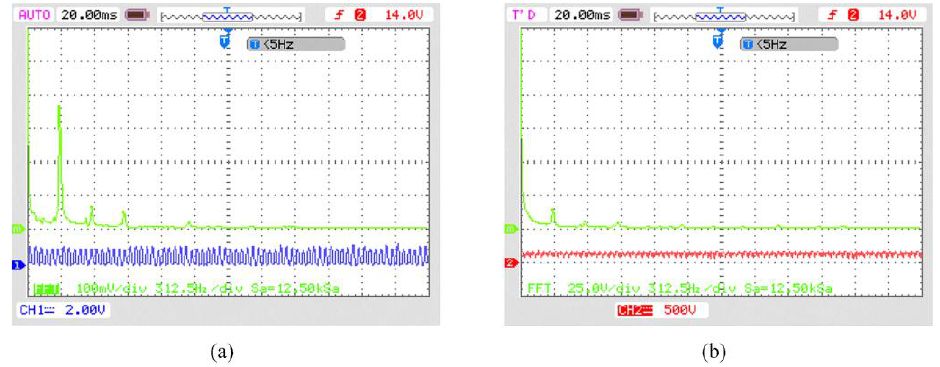
Figure 12. Frequency spectra of input current ( a ) and voltage ( b ) waveforms; the firing angle equal to 60°; motor idling speed.